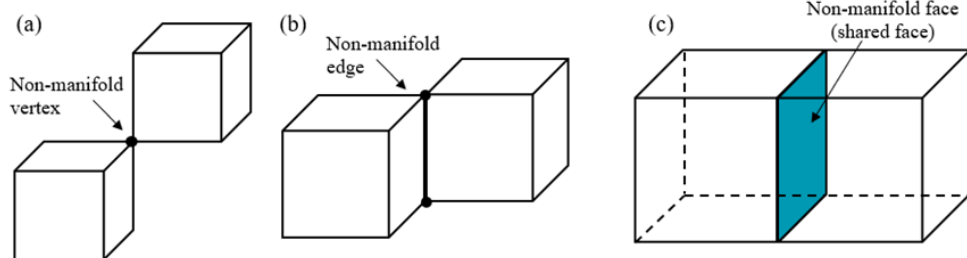
Figure 3. A non-manifold object formed by sharing ( a ) a vertex; ( b ) an edge; ( c ) a face. Due to the internal boundary material ambiguity, the LMC model appears as a “finite non-manifold”, i.e., it is simply limited to the presence of shared boundaries between material regions as shown in Figure 3c. Our goal is to design efficient and simple topolog- ical data structures for the finite non-manifold characteristic. The current non-manifold data structures are classified as the edge-based data structure and the face-based data